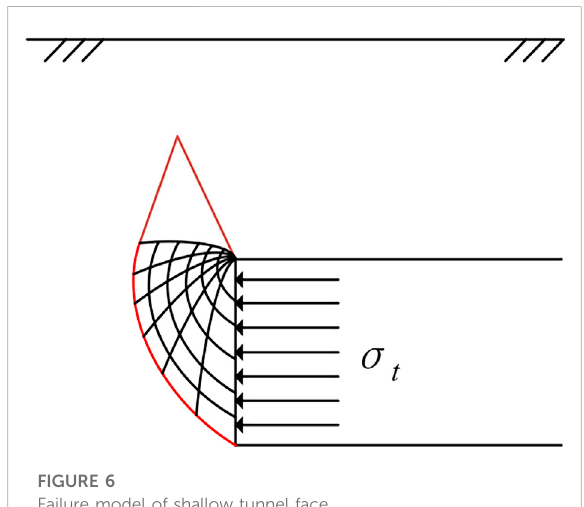
FIGURE 6 Failure model of shallow tunnel